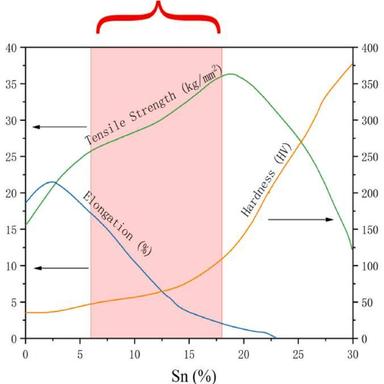
Diagram showing change of mechanical properties of bronzes with tin contents. The tin content of the forged bronzes studied here (ranging from 6 to 18%) is highlighted.